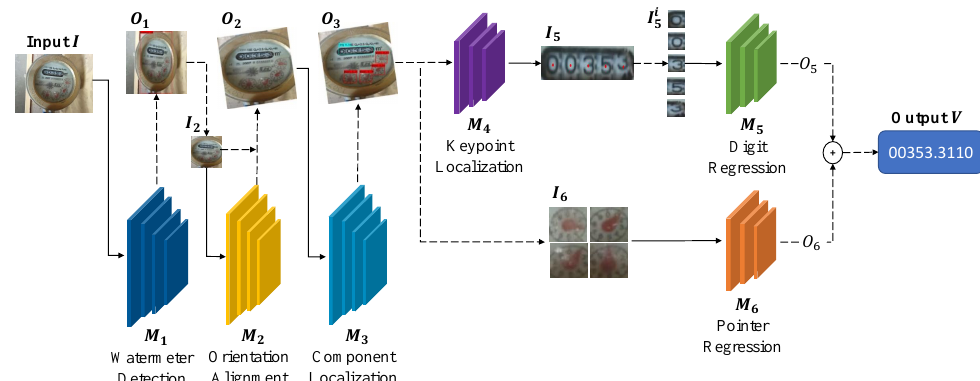
Figure 3. The pipeline of our framework. Our model takes a watermeter image I as input and outputs the corresponding value V . First, the detection model M 1 detects the position O 1 of the watermeter, resulting in the cropped watermter image I 2 . Second, the orientation alignment module M 2 is adopted to get the aligned image patch O 2 . Then, the component localization module M 3 predicts and locates the digit box I 5 and the regions of pointer meters I 6 . Next, the keypoint localization model M 4 is introduced to localize and separate each digit in I 5 . Finally, the values O 5 and O 6 are obtained by the digit reading model M 5 and the pointer reading model M 6 , respectively. The final prediction V is the sum of O 5 and O 6 .